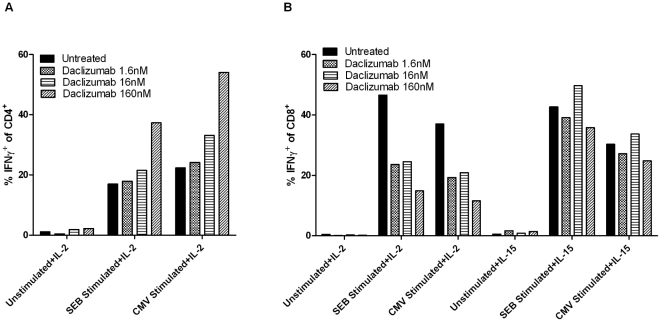

In vitro effects of IL2Rα inhibition on CD4+, CD8+ and regulatory T-cells.Normal donor peripheral blood mononuclear cells (PBMCs) were cultured for 48 hours with increasing concentrations of daclizumab followed by an additional 14 days stimulation/expansion with CMV pp65 RNA-pulsed DCs along with IL-2 or IL-15. PBMC were then isolated and stimulated for 6 hours with SEB or pp65 peptide mix in the presence of CD28/CD49d costimulation and Brefeldin A. The IFN-γ secretion of (A) CD3+CD4+CD69+ or (B) CD3+CD8+CD69+ T-cells was determined by flow cytometry.